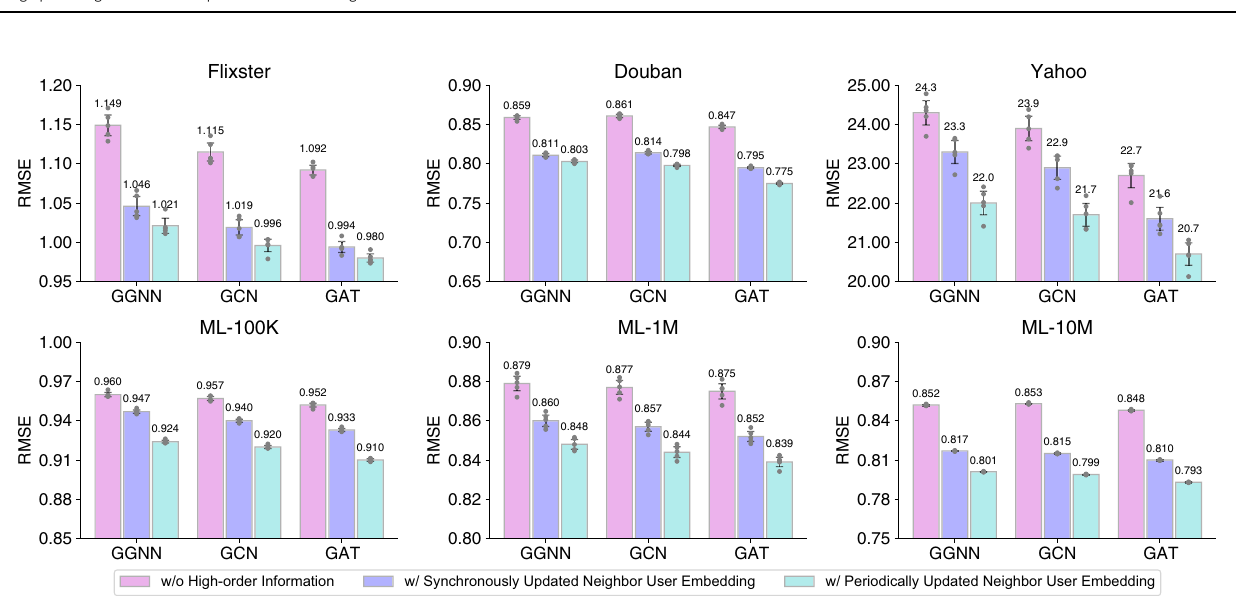
Fig. 2 In fl uence of neighbor user information and different GNN architectures. The error bars represent mean results with 95% con fi dence intervals ( n = 5 independent experiments). GGNN gated graph neural network, GCN graph convolution network, GAT graph attention network. The results show that incorporating the high-order information encoded in neighbor user embeddings can effectively reduce prediction errors, and using periodically updated neighbor user embedding is better than using synchronously updated